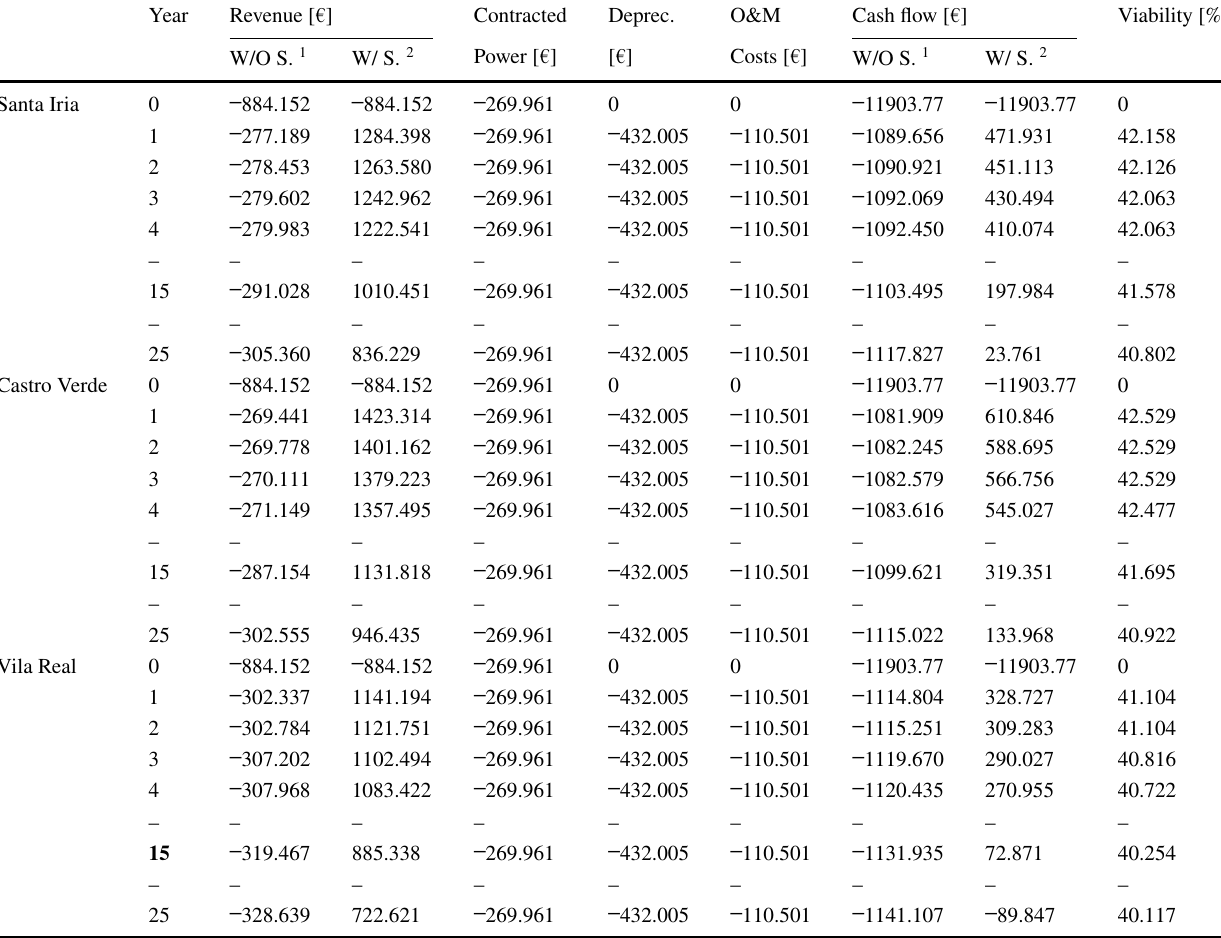
Table 11 CsPbI 3 QDs: Initial Investment = 10800.134 €: 1 Without selling the surplus energy to the grid; 2 With selling the surplus energy to the grid